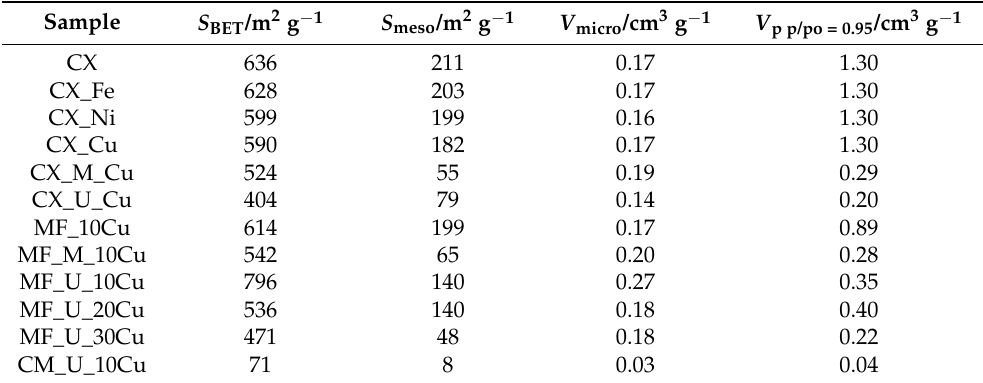
Table 1. Textural properties of the catalytic